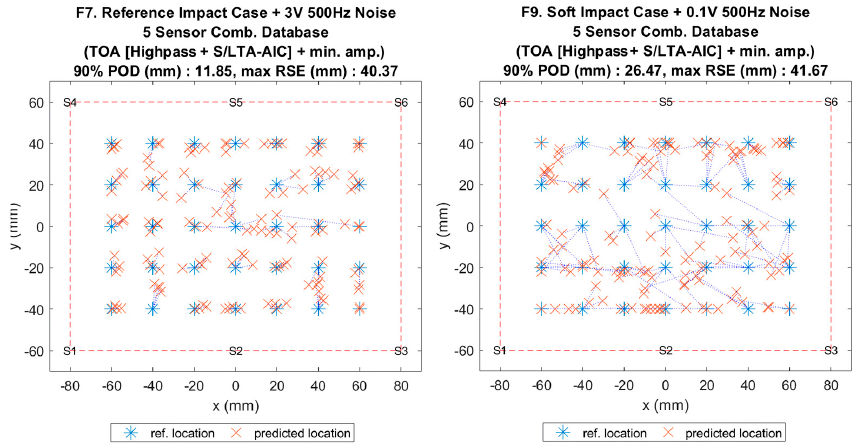
Figure 13. Visualisation of impact localisation for soft impacts (F8) using different input features: NSET extracted ToA (left) and S/LTA-AIC extracted ToA with normalized minimum amplitude (right).